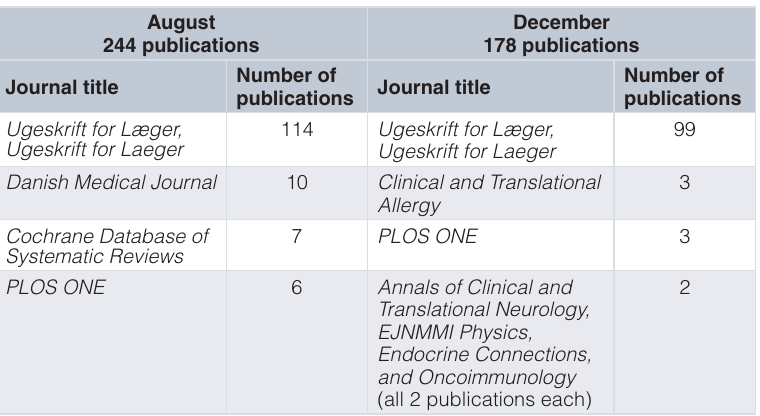
Table 7b. Top journals according to number of publications for publications with UIDs exported from Pure to SciVal and not matched. Download from August and